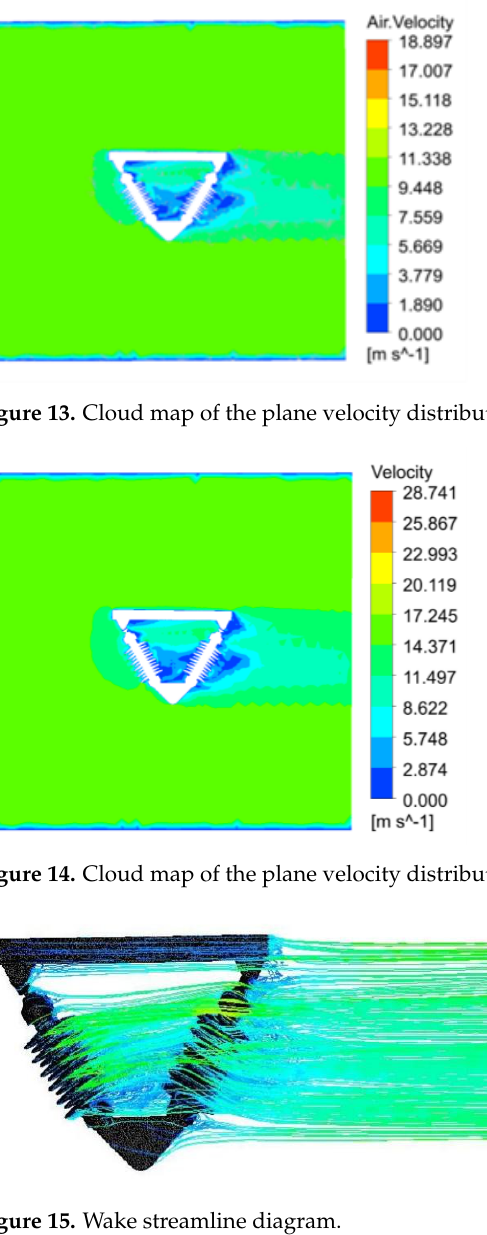
Figure 15. Wake streamline